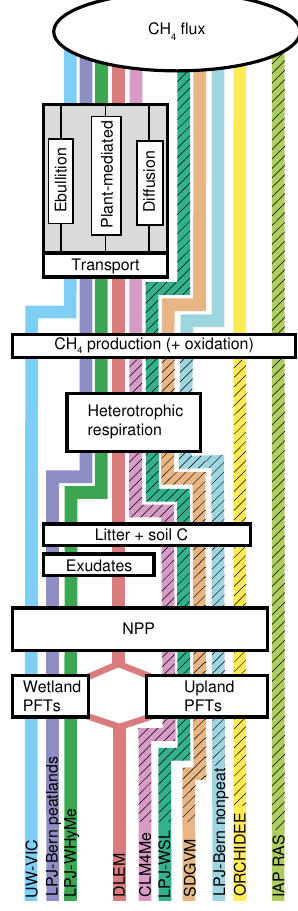
Fig. 7. Conceptual overview of the pathways from the carbon source to “CH 4 flux” (CH 4 flux per m 2 of wetland) in the participating models. Each model (and in some cases, version) is represented by a different colour. The flow of a particular model starts with the model’s name. The hatching of the lines indicates that the CH 4 model is not influenced by wetland hydrology (beyond changes in extent). “Wetland PFTs” means that the model uses wetland-specific PFTs, whereas “Upland PFTs” indicates that the model uses the already existing PFTs used for upland ecosystems. “NPP” stands for net primary production, “Exudates” are root exudates carbon pool. All models but the IAP-RAS model use NPP as a precursor of the carbon used directly in CH 4 production or indirectly in CH 4 production by estimating “Litter and Soil C”, “Exudates”, and “Heterotrophic respiration”. The models then calculate “ CH 4 production” and the oxidation based on the equations given in Table 5. Some models include the effect of “Transport” mechanisms explicitly, whereas others include transport only implicitly by either producing less CH 4 or oxidizing it before emitting it to the atmosphere. All models use some sort of temperature dependence when calculating NPP, heterotrophic respiration, and/or CH 4 production. In this figure, LPJ-Bern “nonpeat” includes both wetlands and wetsoils, which also incorporate plant exudates (graphical simplification).